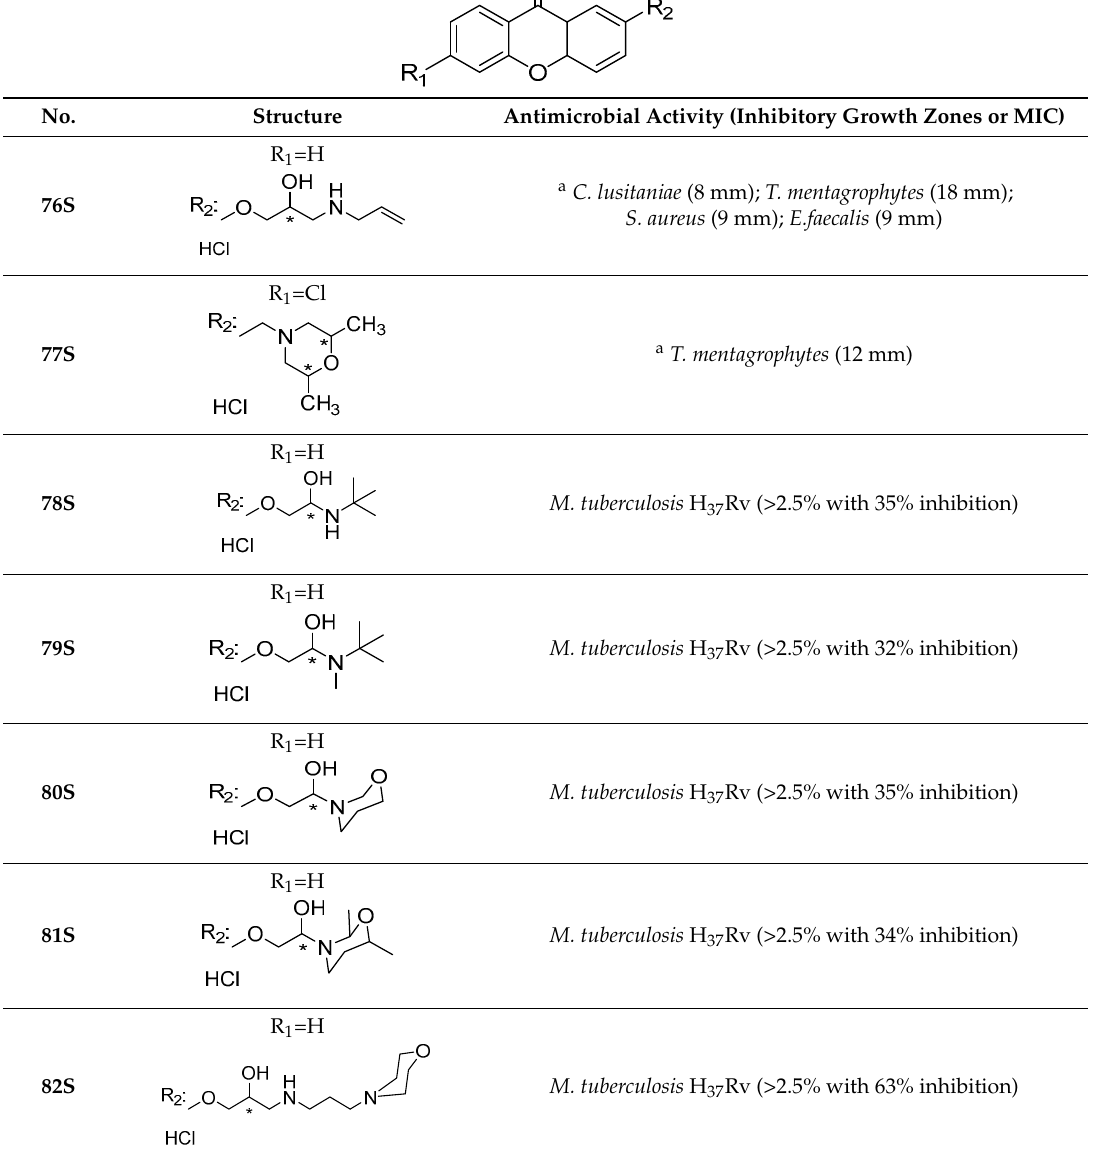
Table 13. Antimicrobial activity of xanthone derivatives of C-2-substituted.